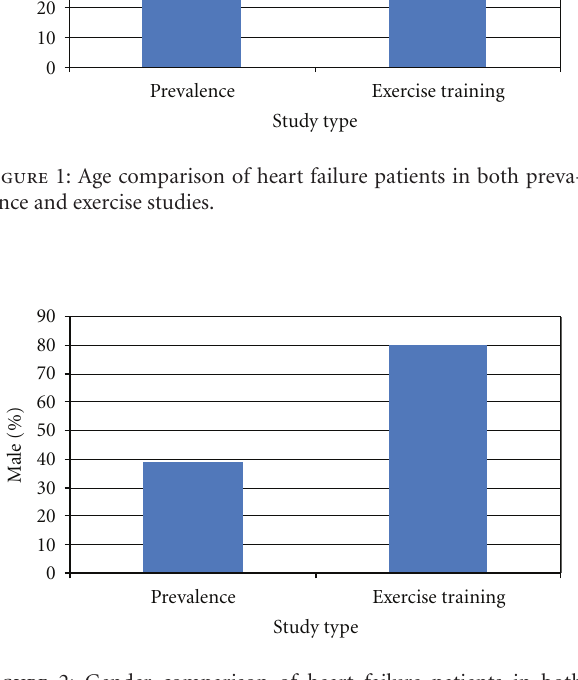
Figure 2: Gender comparison of heart failure patients in both prevalence and exercise